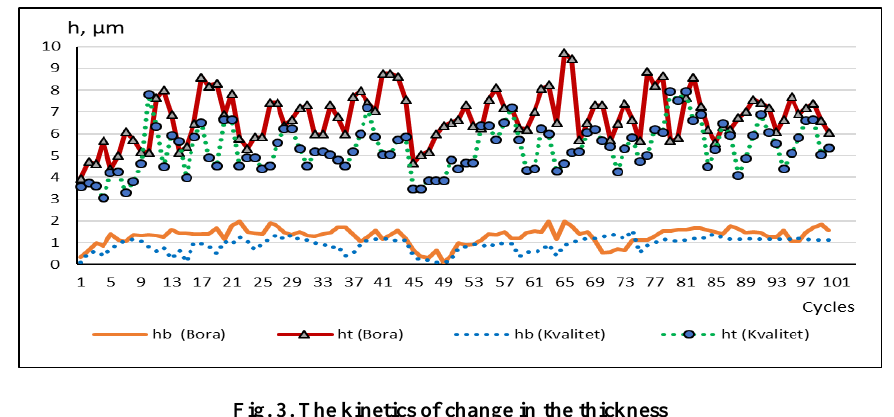
Fig. 3. The kinetics of change in the thickness of the boundary adsorption layers ( h b ) and the total